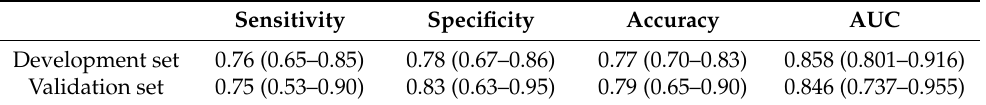
Table 2. Diagnostic performance of radiomics